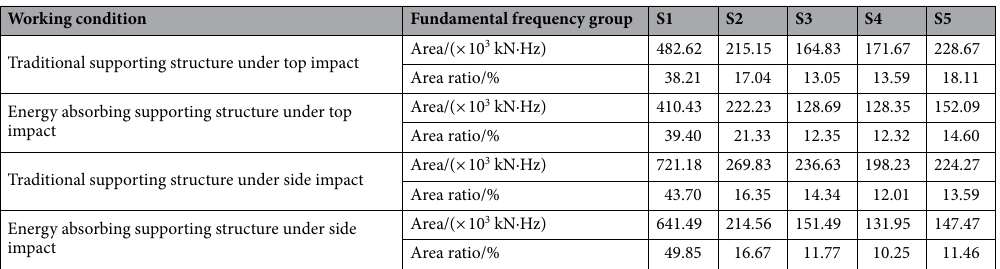
Table 1. Calculation results of fundamental frequency group